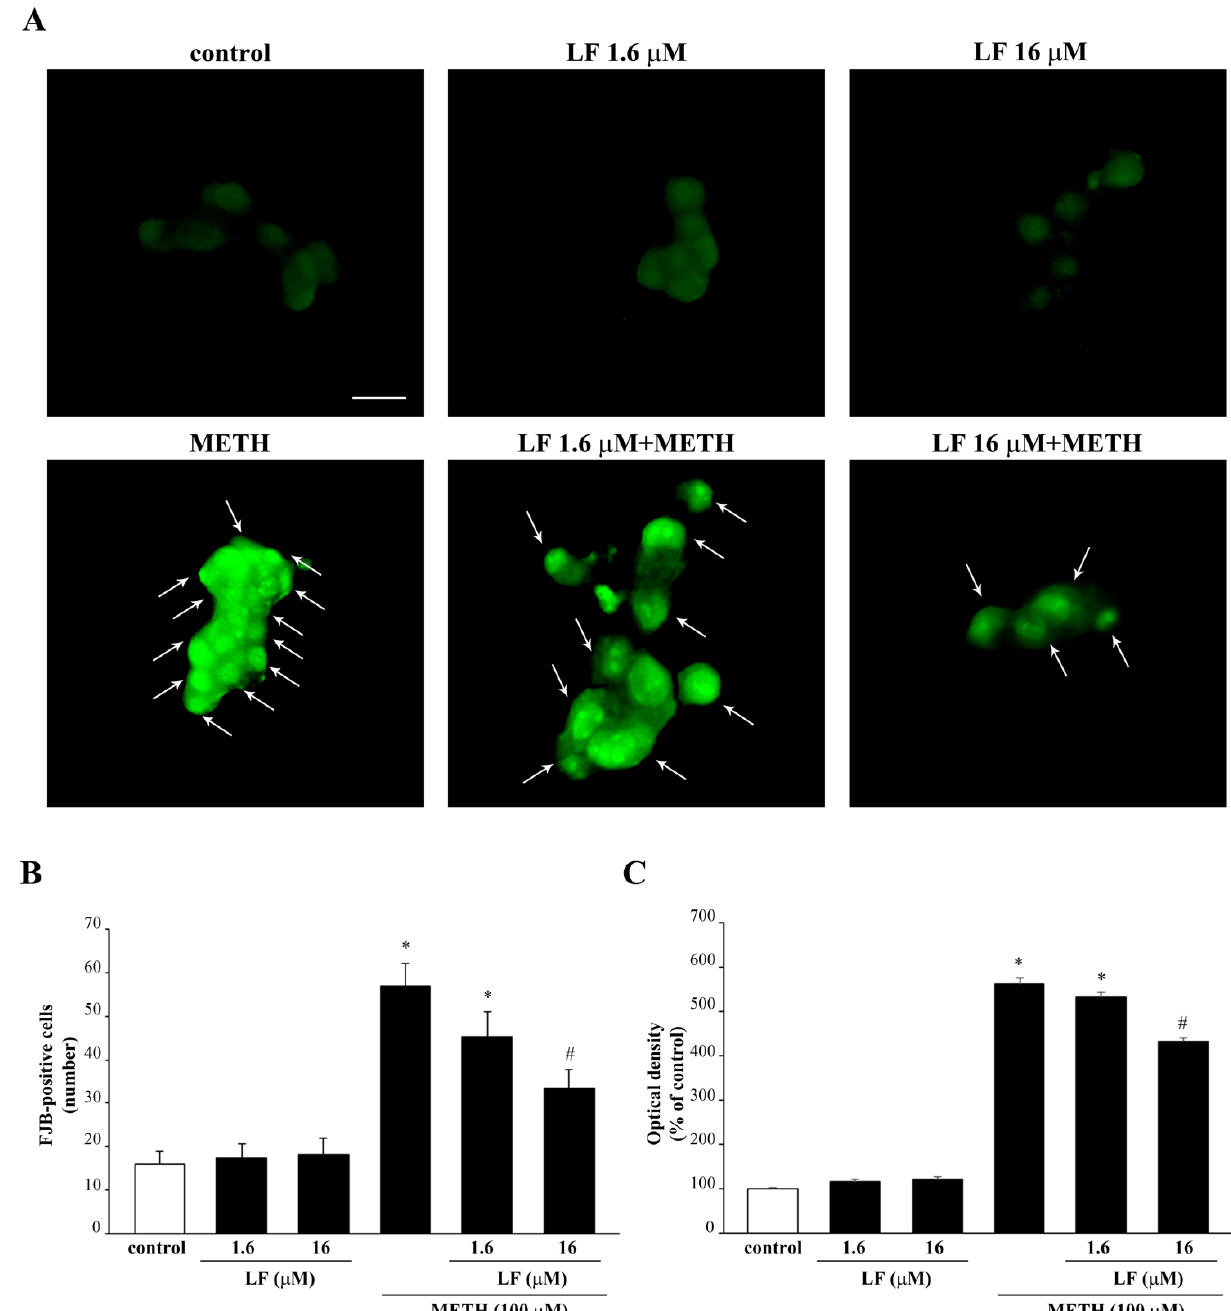
Figure 5. LF decreases METH-induced FJB-responsiveness in PC12 cells. ( A ) Representative pictures of FJB-stained PC12 cells after combined LF and METH treatment. The graphs ( B , C ) report the number and the intensity of FJB fluorescent cells, respectively. Arrows indicate FJB intensely positive cells. * p < 0.05 compared with control; # p < 0.05 compared with control and METH. Scale bar = 15 μ M.